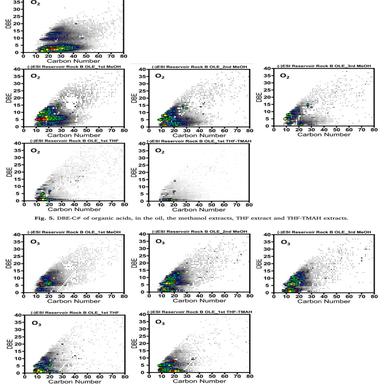
DBE-C# plots of O3-5S1 species in the methanol extracts.